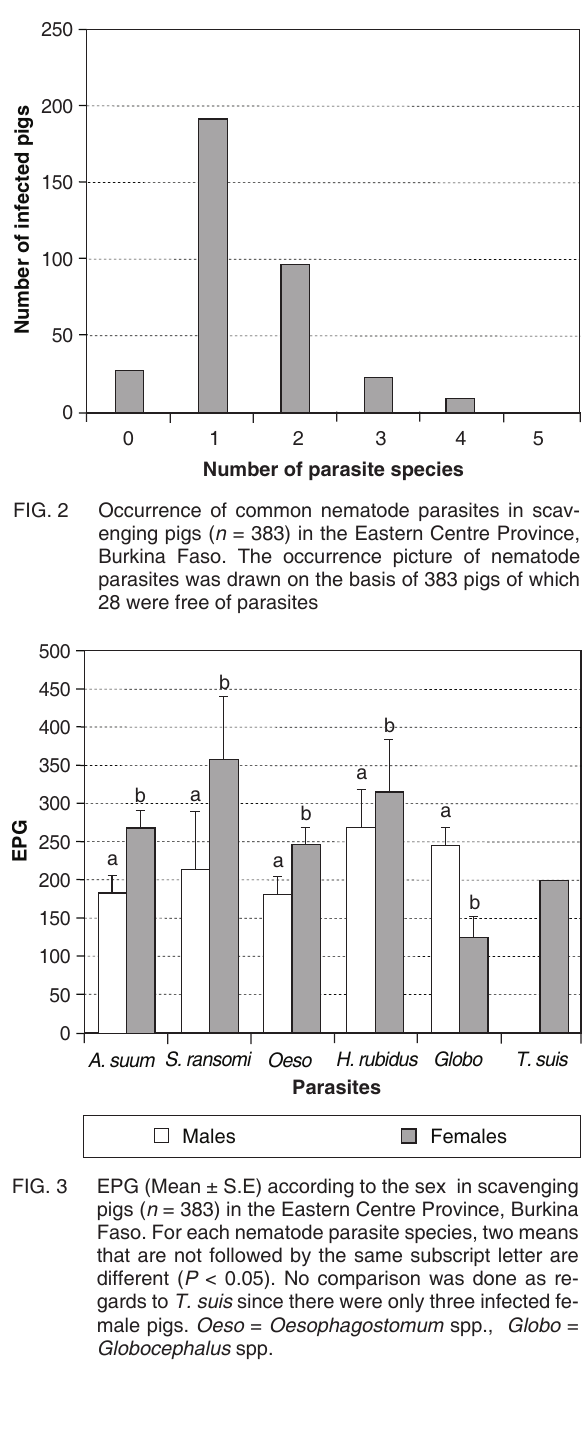
for Globocephalus spp. The results are shown in Fig. 3. Effect of age on EPG